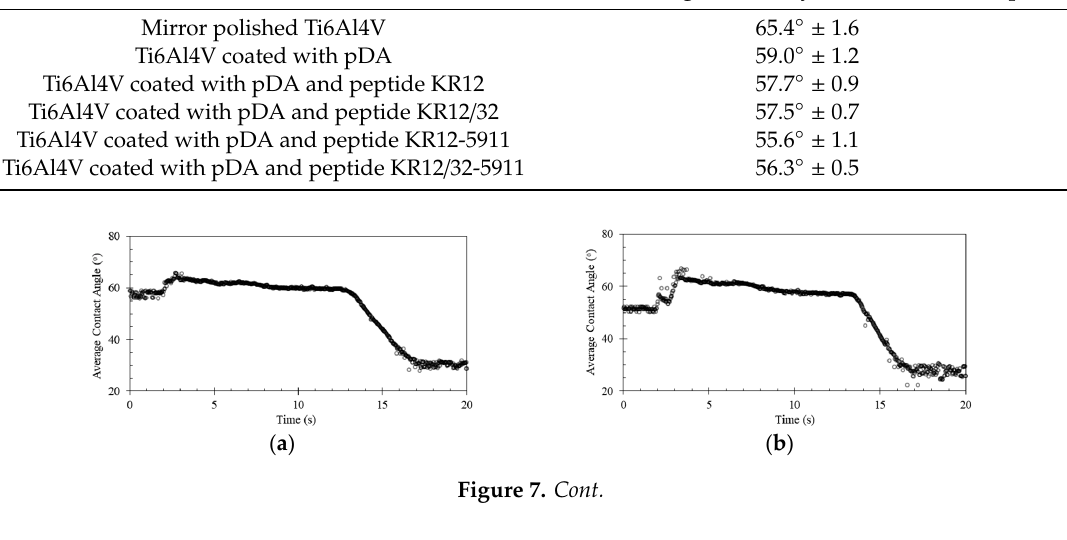
coated Ti6Al4V surface based on HPLC; x-axis displayed in logarithmic scale (base = 12).